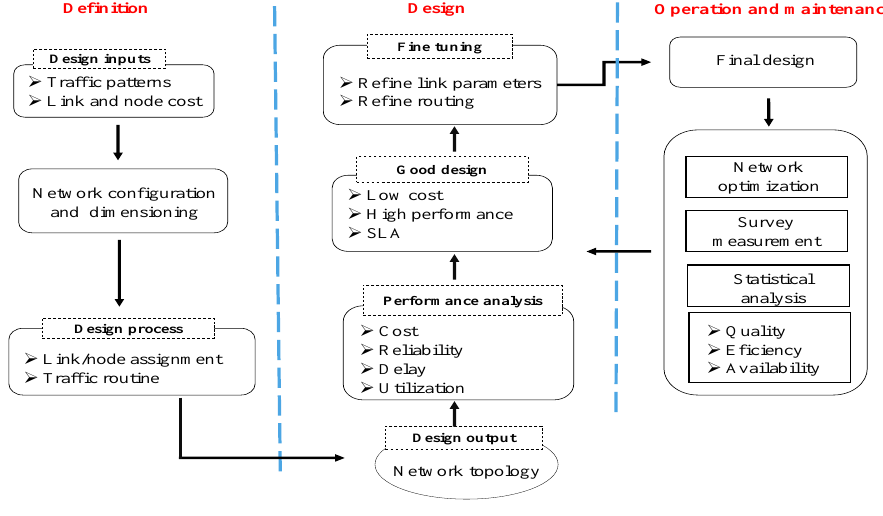
Figure 2. Steps involved in facility location in